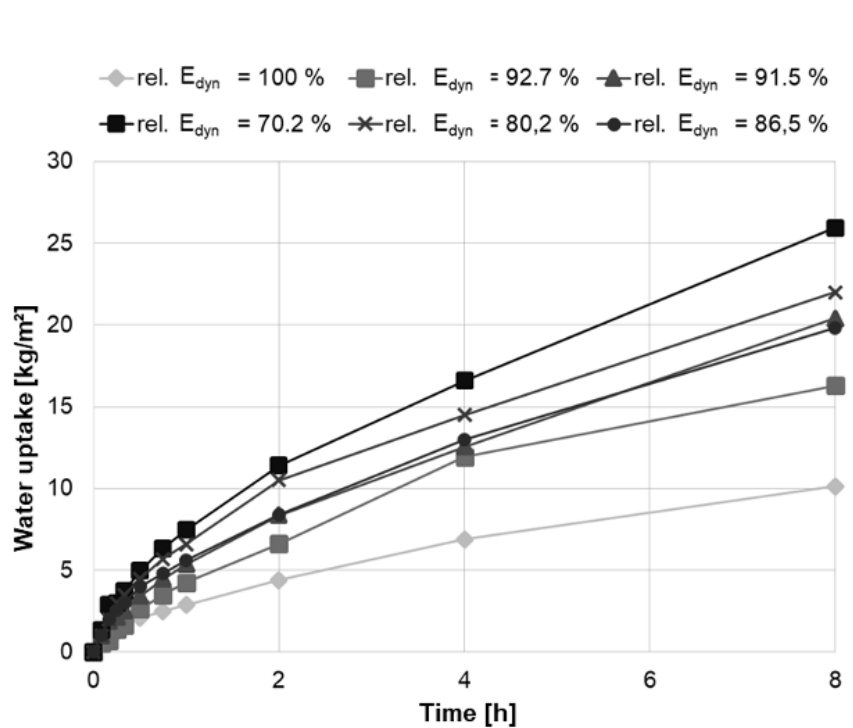
Figure 4. Water uptake in concrete with di ff erent relative dynamic E-Modulus.